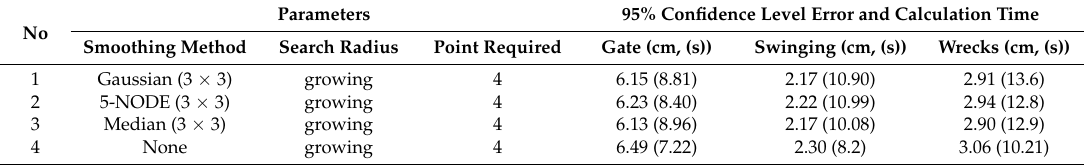
Table 3. The comparison of the modified kriging results with and without smoothing (95% confidence level error and